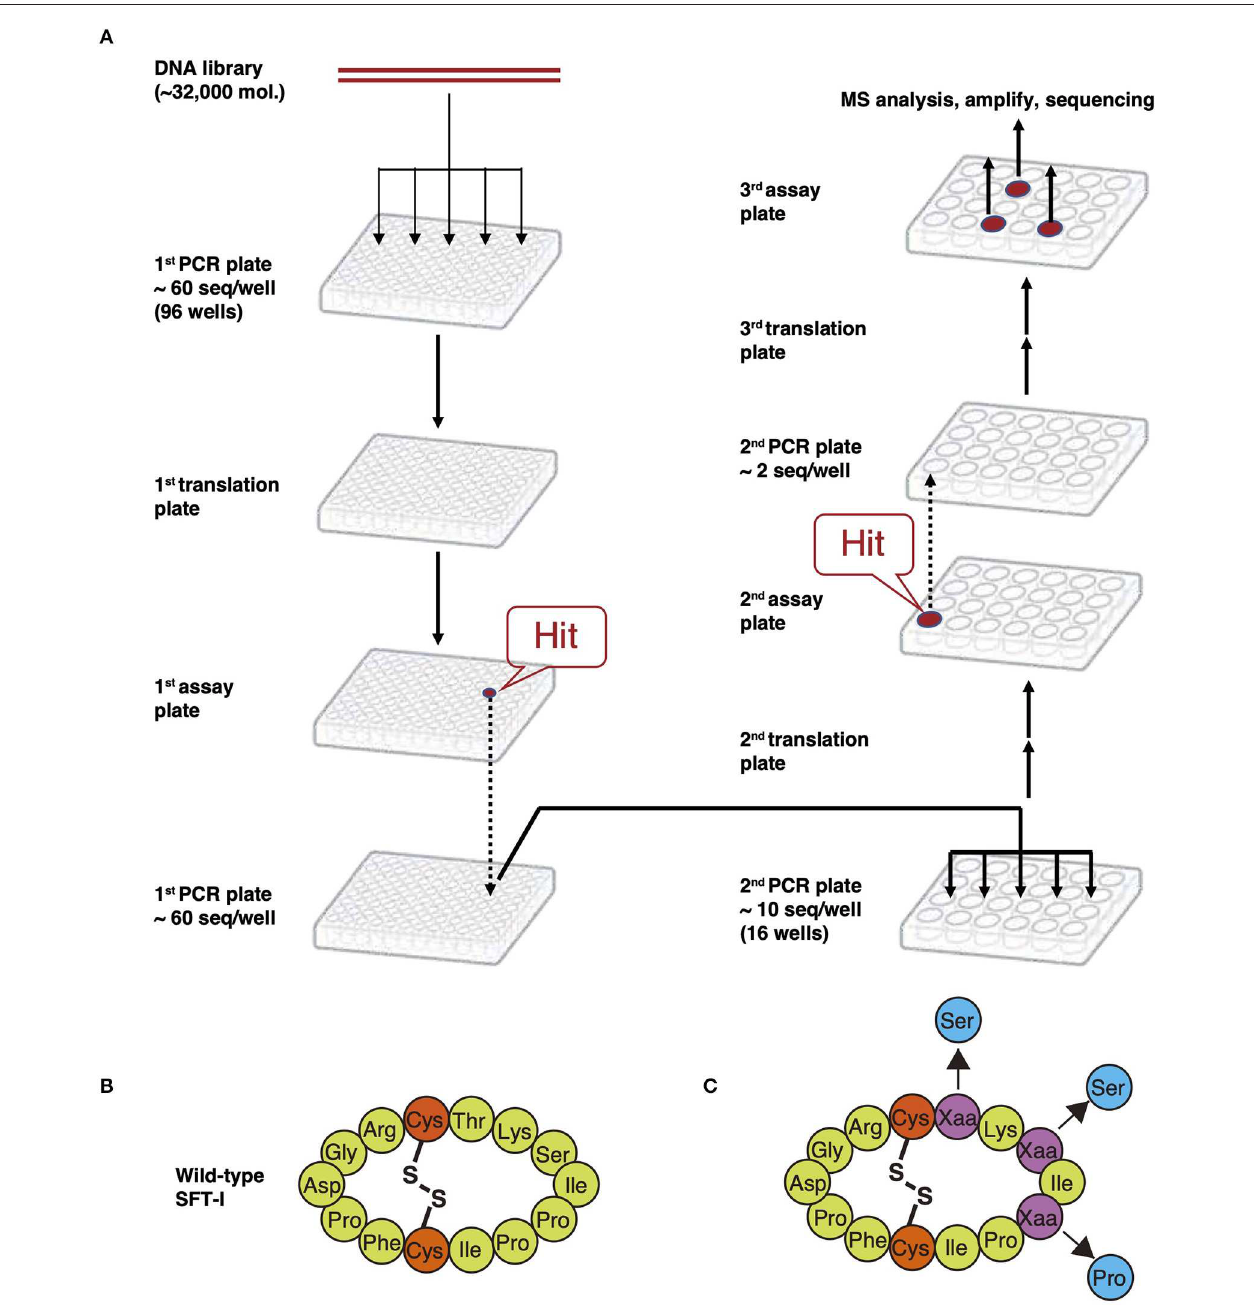
FIGURE 10 | Limiting-dilution PCR deconvolution technology. (A) The procedures of limiting-dilution PCR. An mRNA library is transcribed from the corresponding DNA, which is separated into a 96-well plate in advance. Then, the mRNAs are translated to the peptides, and which are subsequently assayed separately in each well. The DNA in wells containing hit compounds is amplified by PCR to produce the next DNA library encoding more active peptides than the previous DNA library. This new library is then split into a new 96-well plate, and the cycle is repeated. The high-activity peptides converged after repeated cycles are identified by MS analysis and sequencing. (B) Structure of wild-type SFT-1. (C) Backbone macrocyclic peptide library based on SFT-1 sequence. Purple Xaa circles mean the randomized amino acids. Blue circles mean the mutation of amino acids on the obtained mutant SFT-1.